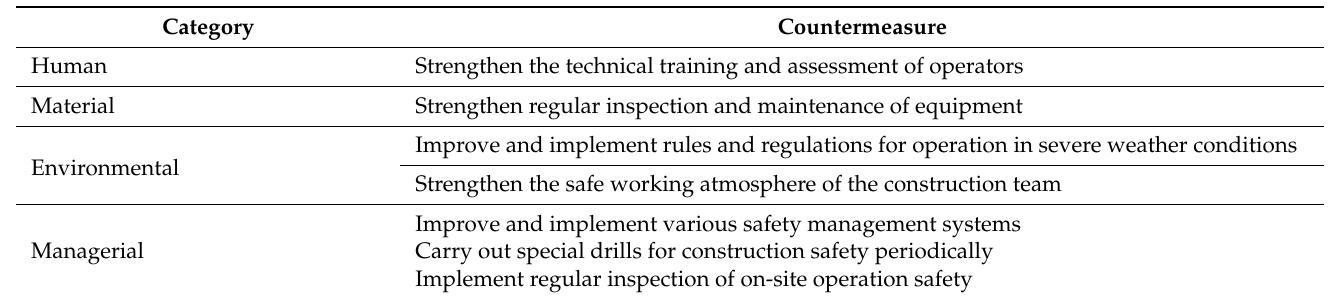
Table 13. A summary of countermeasures for workers’ unsafe behaviors in hoisting